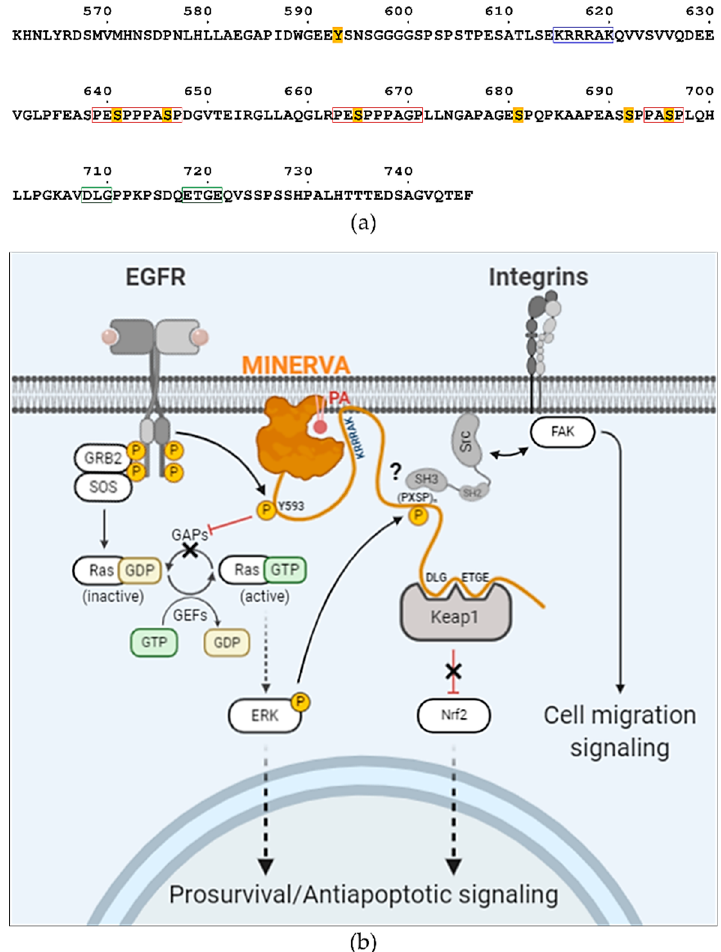
Figure 6. Proposed role of the flexible C-terminal region in functional regulation of MINERVA. ( a ) Amino acid sequence of the C-terminal flexible region (Lys561–Phe574) is shown with known posttranslational modification sites and characteristic sequence motifs. Phosphorylation sites are highlighted in yellow. Short stretch of positively charged residues are in blue frame. Tandem SH3 domain-binding “(PXXPP)P ψ XP” motifs are in red frames. Keap1-interacting “DLGX n ETGE” motif is in green frame. ( b ) Schematic summarizing known and proposed MINERVA function as a regulator of cell signaling. MINERVA is shown in orange.